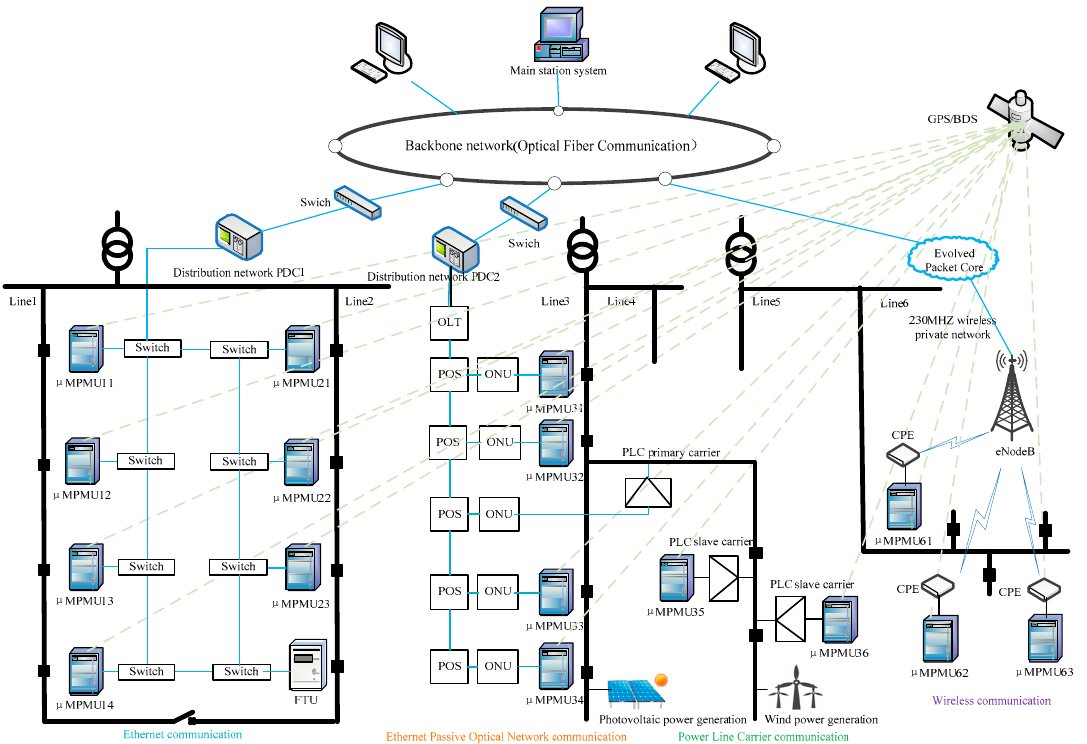
Figure 1. Distribution network WAMS organizational structure.